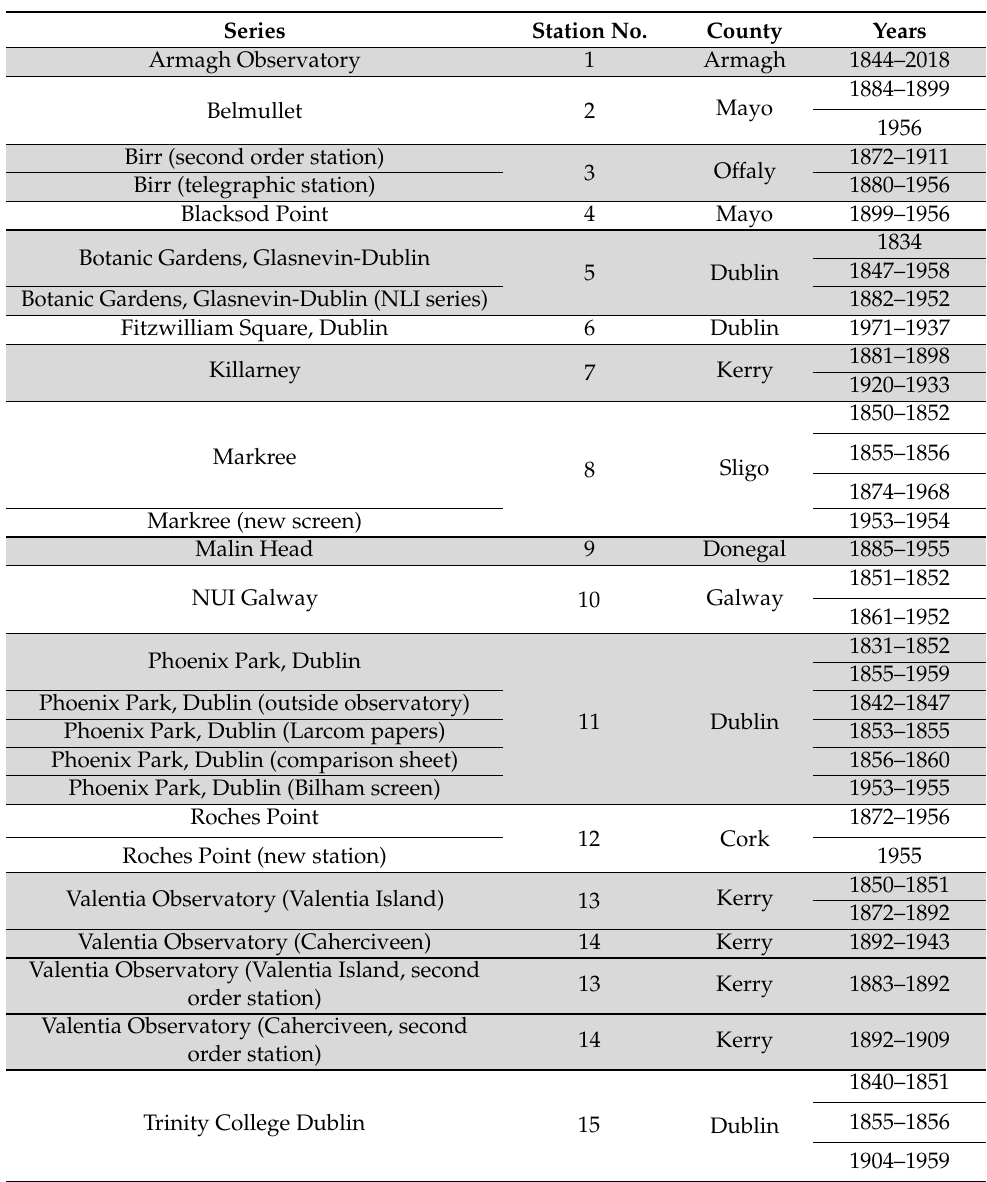
Table 1. Historical quality-controlled long-term daily MAX and MIN